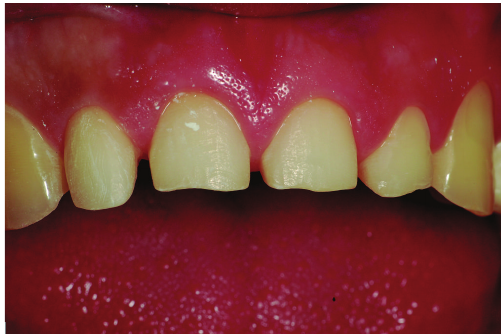
Figure 6: Frontal view of the maxillary prepared teeth.